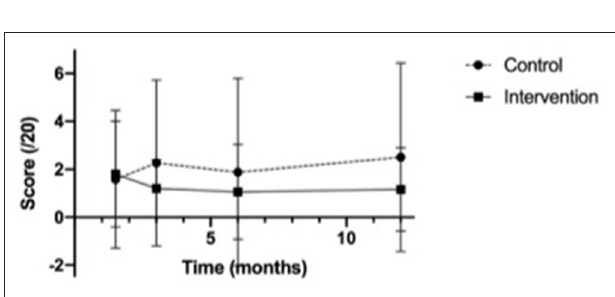
FIGURE 3 | Change in mean multiple choice question knowledge test scores from